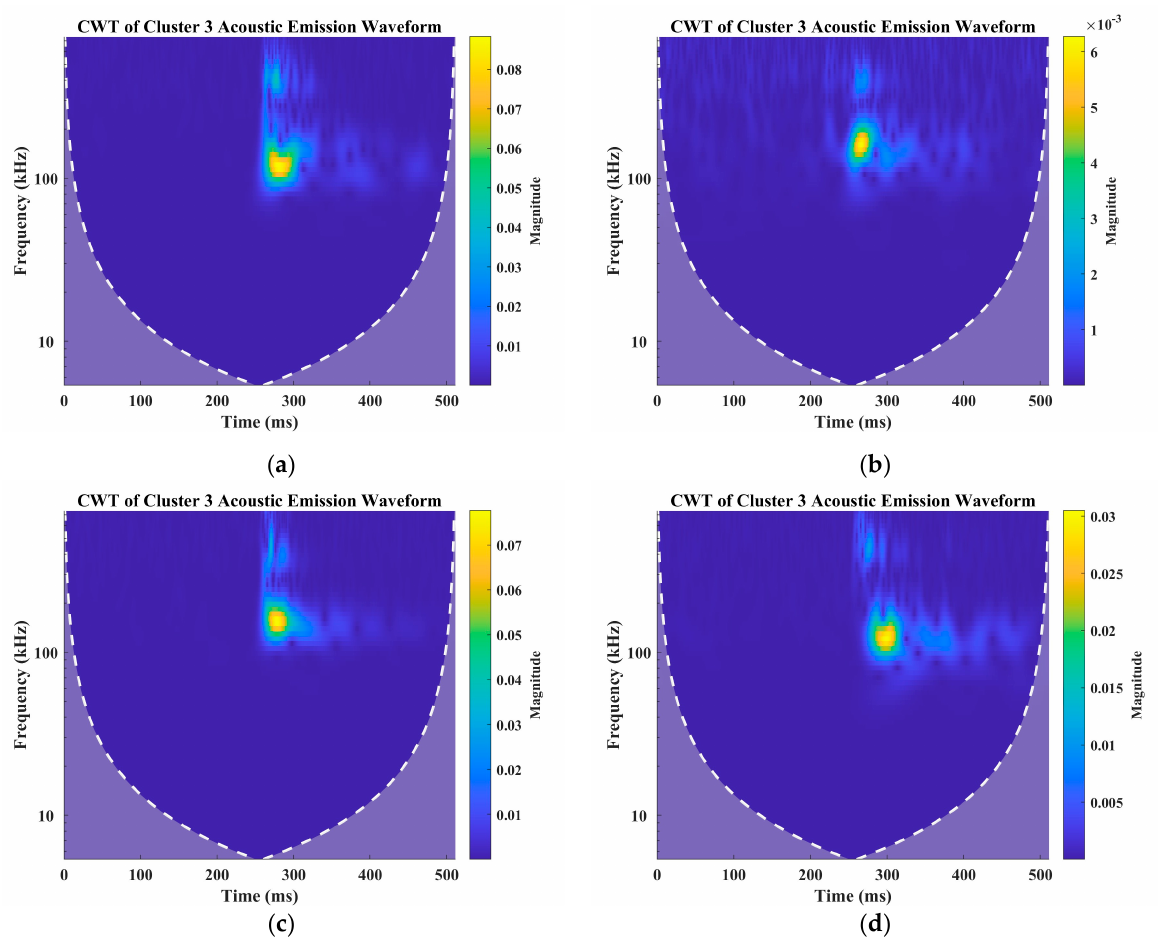
Figure A4. CWT spectrograms of four randomly selected AE signals ( a ) Signal 1; ( b ) Signal 2; ( c ) Signal 3; ( d ) Signal 4 from Cluster 3.